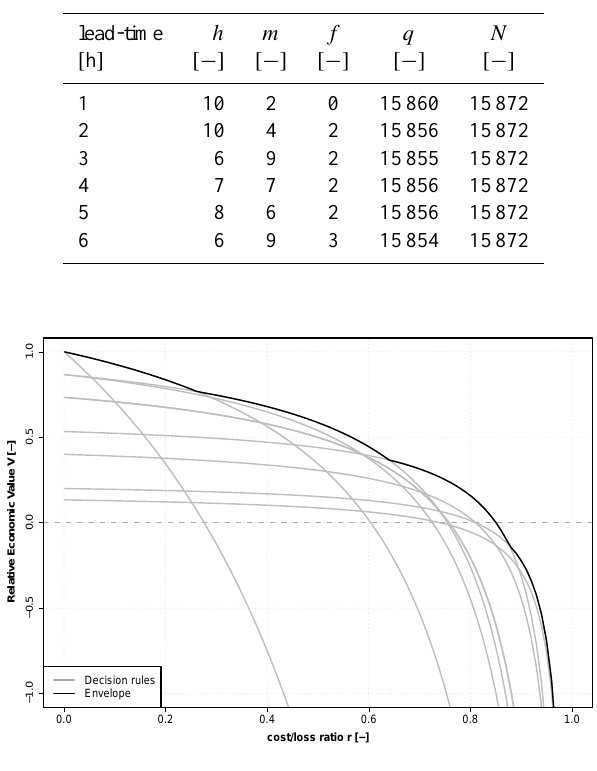
Fig. 8. Relative economic value as a function of cost-loss ratio for decisions based on probabilistic forecasts with a 3-h lead-time. The grey lines correspond to the values of V for each of the decision rules P ≥ 0, 0.1, 0.2, ... , 1 (from top to bottom panels). The black line is the envelope of these curves.